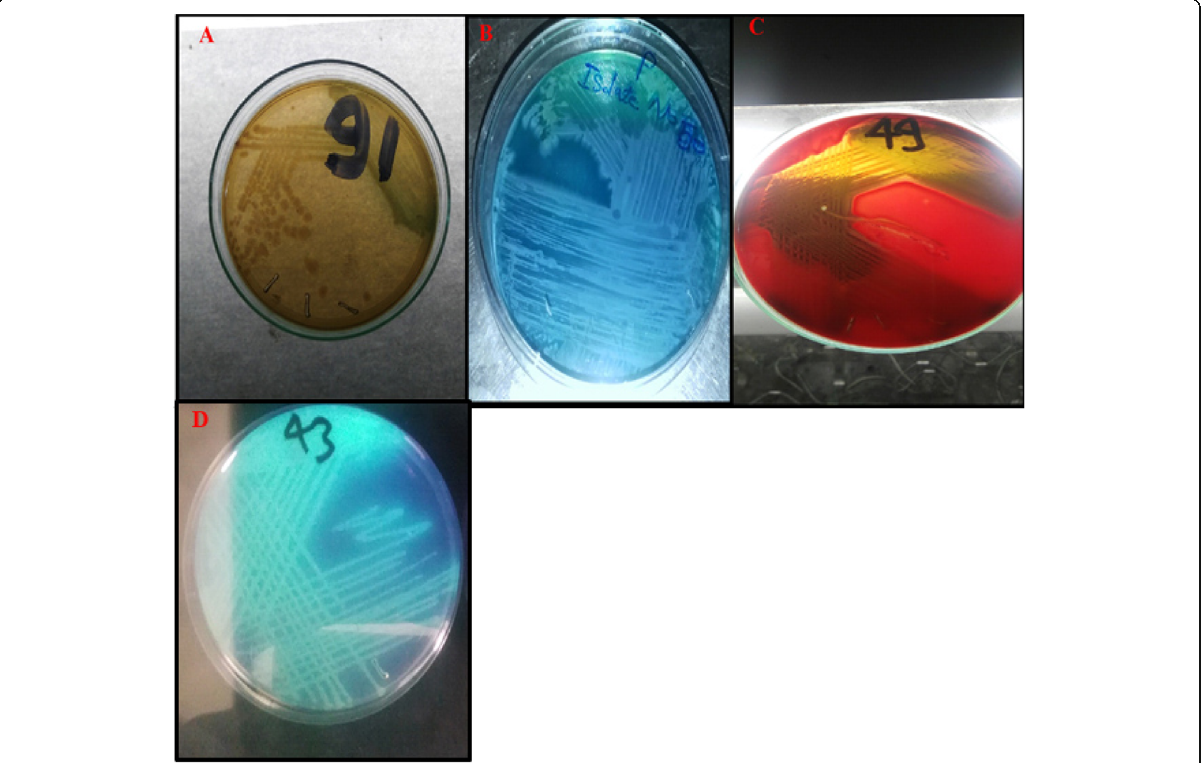
Fig. 1 The colonial morphology of P. aeruginosa isolates on different culture media. a Colorless colonies of P. aeruginosa on MacConkey agar. b Blue pyocyanin pigment production on Pseudomonas aeruginosa (P) agar. c Green metallic sheen colonies of P. aeruginosa on citrated horse blood agar. d The fluorescence characteristics of P. aeruginosa on cetrimide agar under the short wavelength of ultraviolet